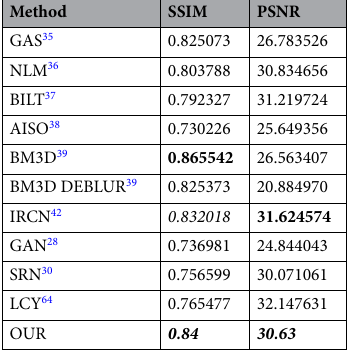
Table 2. Speckle, salt pepper, Poisson noises.